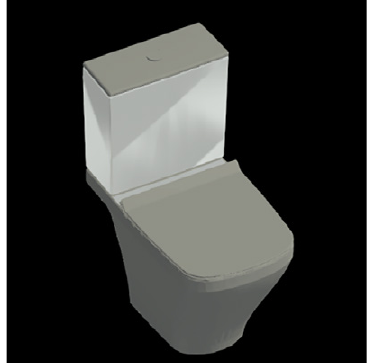
Figure 7. 3D BIM object for